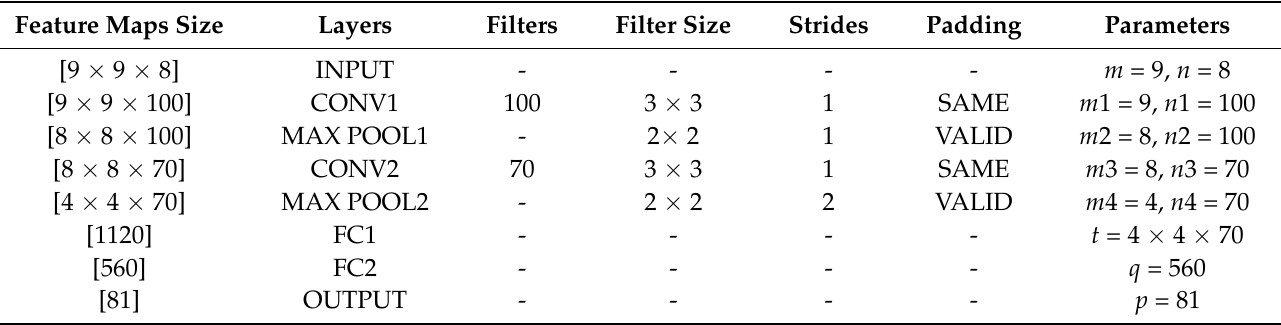
Figure 3. F2F-NN structure diagram, two convolutional layers and max-pooling layers are arranged periodically and finally connected to the fully connected layers. Table 1. F2F-NN network detailed